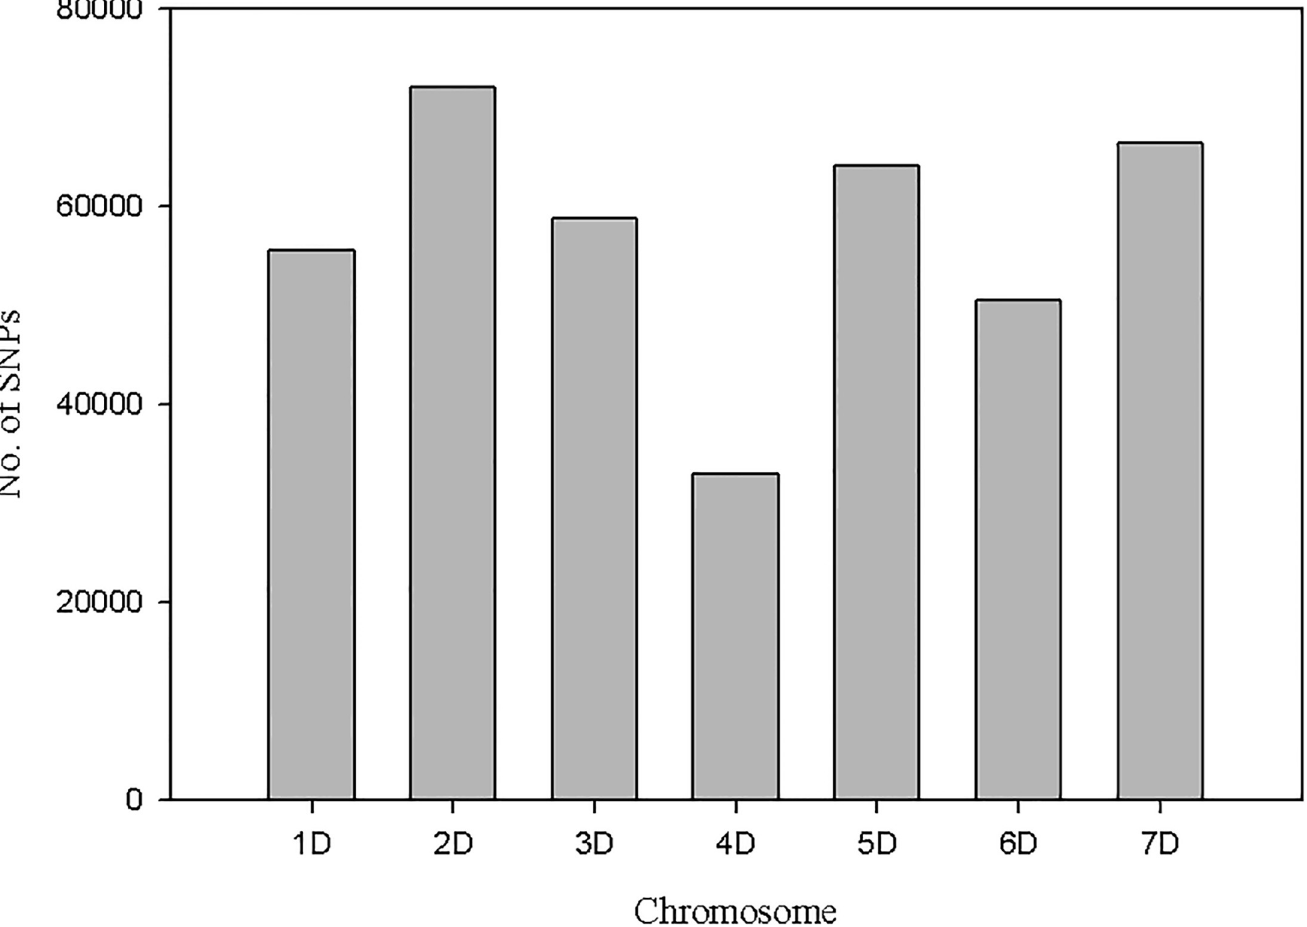
Fig 4. Distribution of SNPs identified from Ae . umbellulata assembly on Ae . tauschii chromosomes.